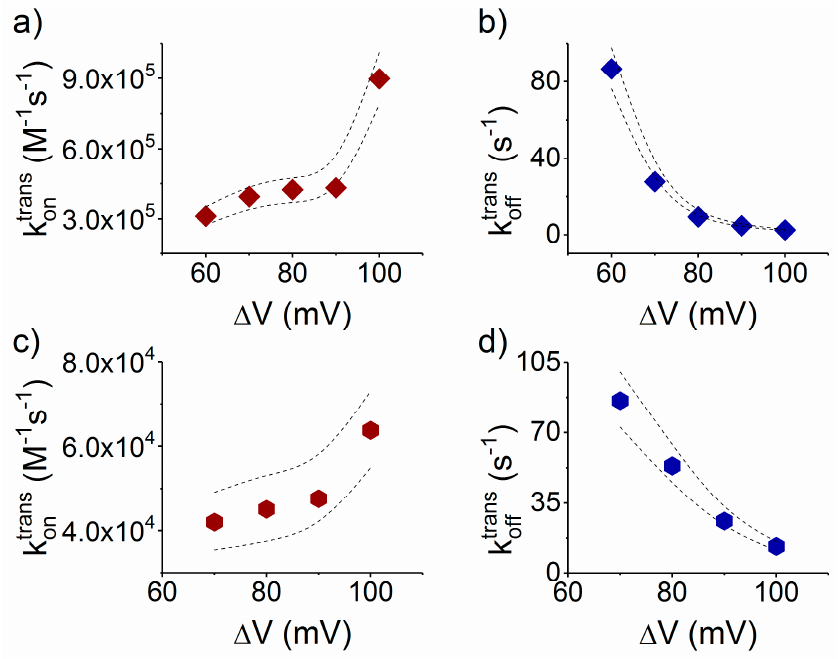
Figure 4. The trans -added, S 6 - and I 6 -containing peptides interact distinctly with the α -HL, despite their net charge and length. From the statistical analysis of the characteristic dwell-times resembling peptides association and dissociation from the nanopore, we calculated values of the voltage-dependent association ( k on ) and dissociation ( k off ) reaction rate constants of: S 6 -(Pe6) ( a , b ); and I 6 -(Pe4) ( c , d ). The dotted lines represent the upper and lower confidence limits mark the 95% confidence intervals for the estimated average values [40].